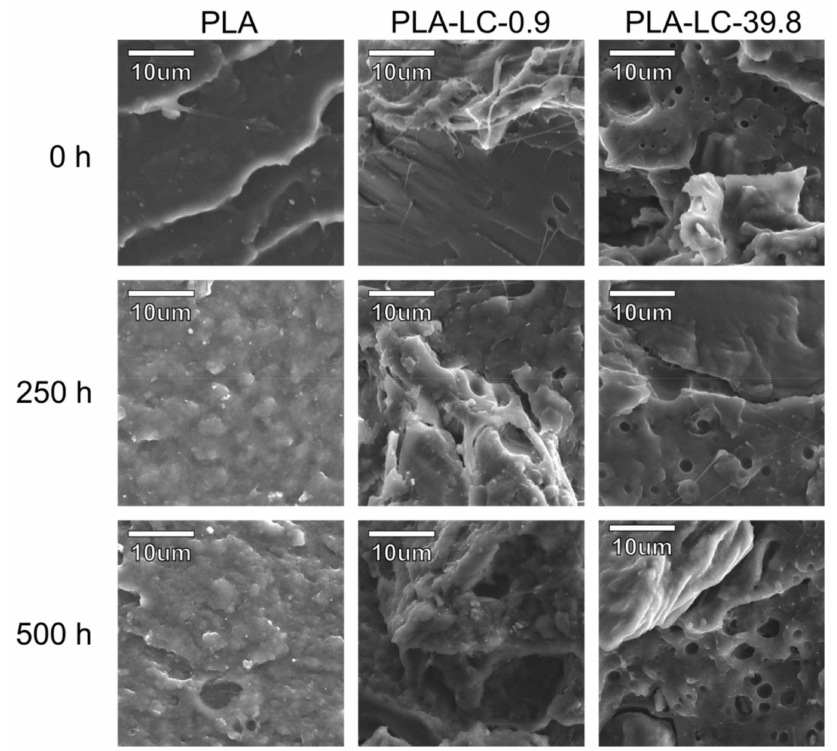
Figure 4. SEM images of the chosen samples weathered for 0, 250, and 500